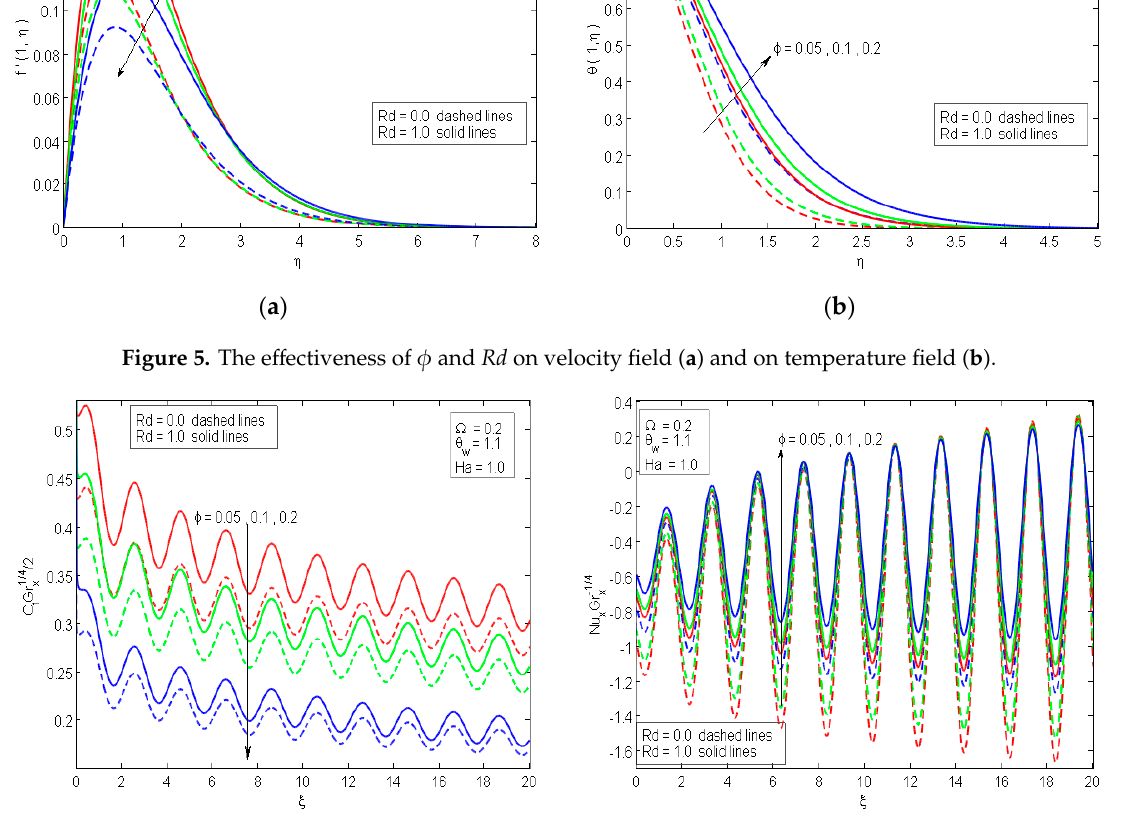
(cid:48) ( ξ , η ) θ on velocity ( , ) f ξη ′ and w θ on velocity ( , ) f ξη ′ and w